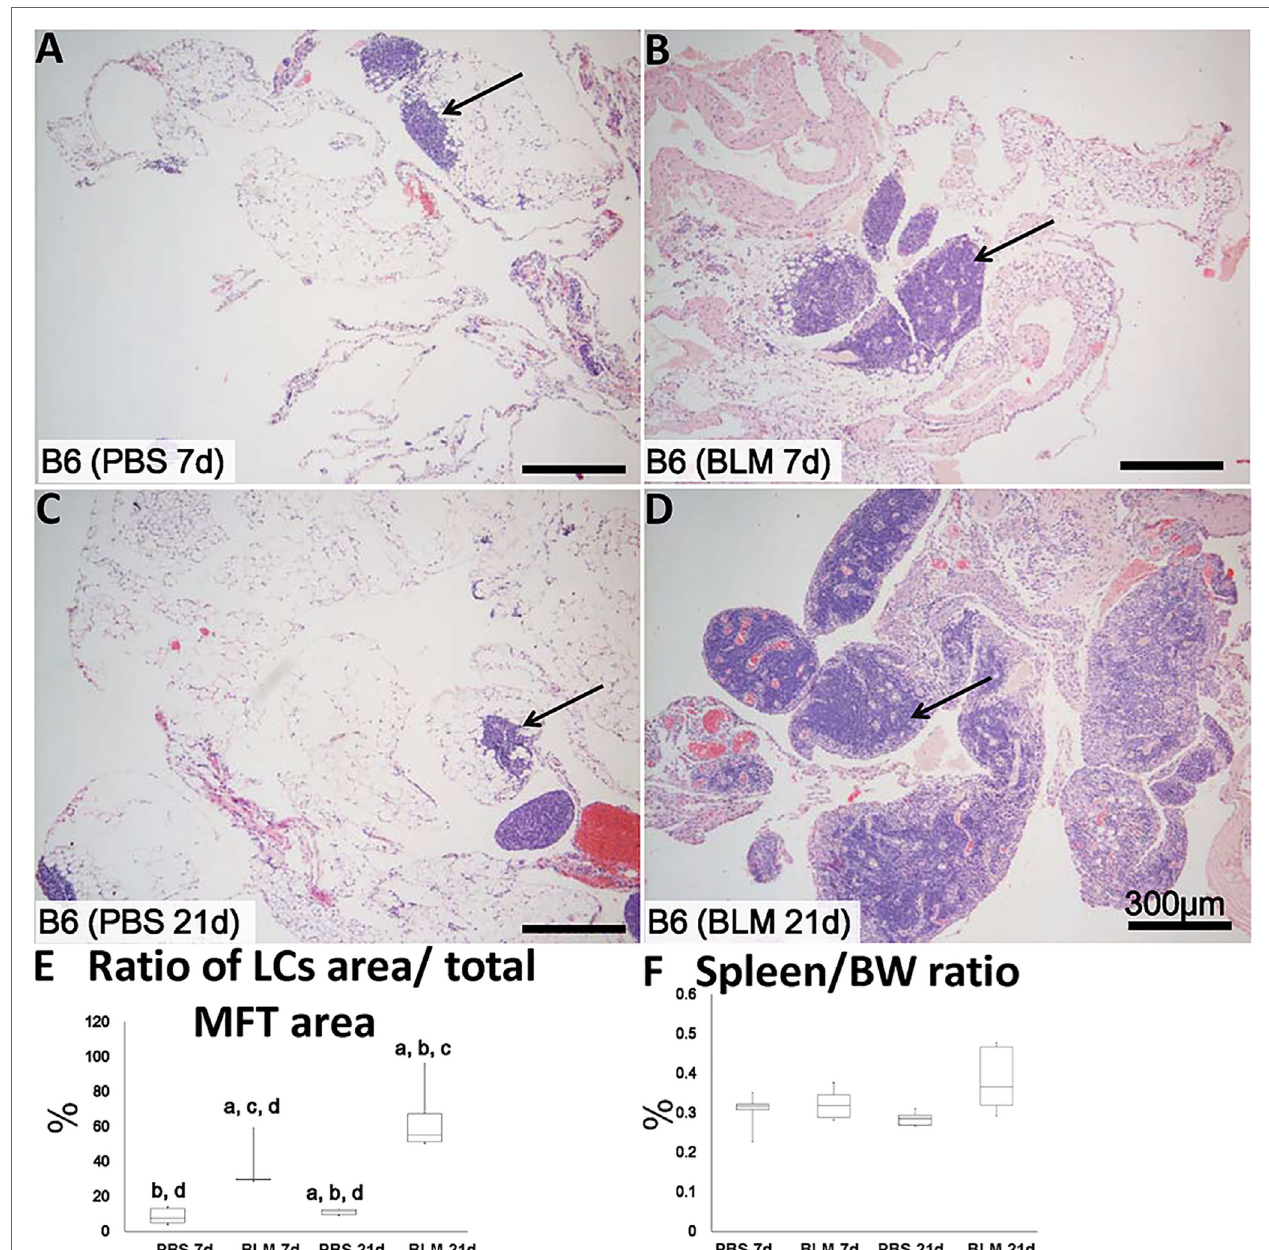
FigUre 2 | Mediastinal fat-associated lymphoid cluster (MFALC) development in Bleomycin (BLM)-induced pneumonitis model mice. H&E-stained mediastinal fat tissue (MFT) at 7 and 21 days following i.n. instillation of phosphate-buffered saline (PBS) (a,c) or 5 mg/kg BLM (B,D) . Arrows indicate MFALCs. (e) Ratio of LC area/total MFT area expressed as percentage. (F) Ratio of spleen/body weight expressed as percentage. The letters a, b, c, and d: significant differences between PBS group at 7 days (a), BLM group at 7 days (b), PBS group at 21 days (c), and BLM group at 21 days (d), analyzed by the Kruskal–Wallis test, followed by the Scheffé’s method ( P < 0.05); n = 5 in each experimental group. Values = mean ±